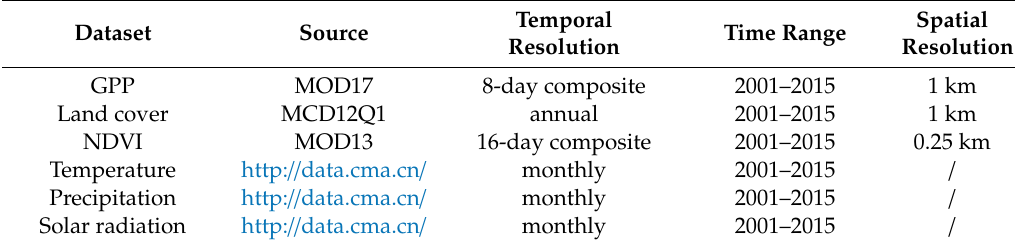
Table 1. Description of the data used in this